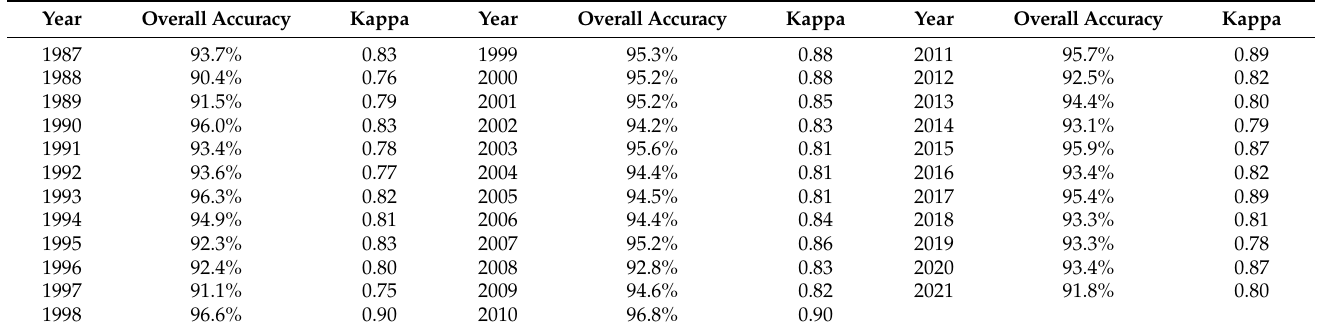
Table 3. 1987–2021 Tidal flats extraction accuracy.